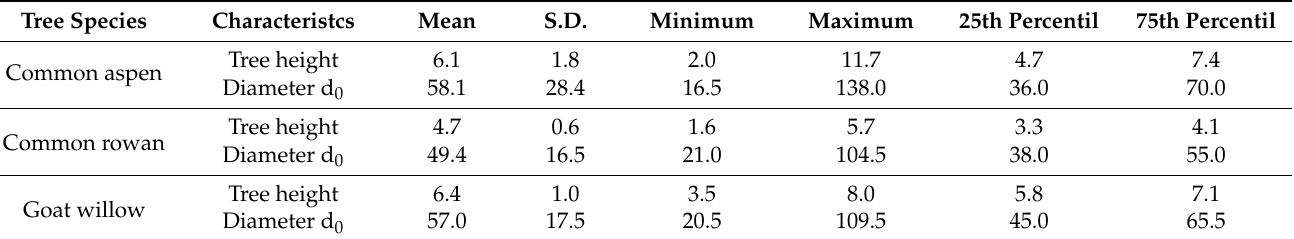
Table 1. Descriptive statistics representing the height (h, m) and stem base diameter (d 0 , mm) of com- mon aspen ( Populus tremula L.), common rowan ( Sorbus aucuparia L.) and goat willow ( Salix caprea L.), in the Hus á rik research-demonstration entity in the Kysuce region; north-western Slovakia.